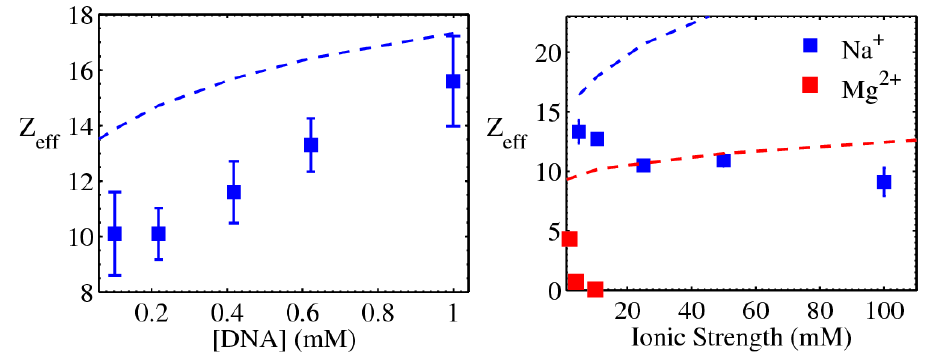
Figure 8. Effective charges (z eff ) determined by SAXS measurements in conjunction with physical modeling. The oligomeric DNA has a bare charge of 48 e. Symbols are experimental values and lines are the renormalized charges. Details of experimental conditions and modeling procedures are described in [91]. Adapted from [91]. Copyright (2006) by the American Physical